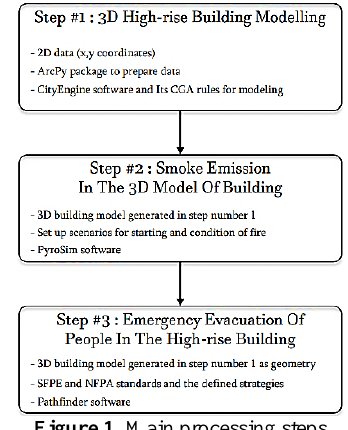
Figure 1. Main processing